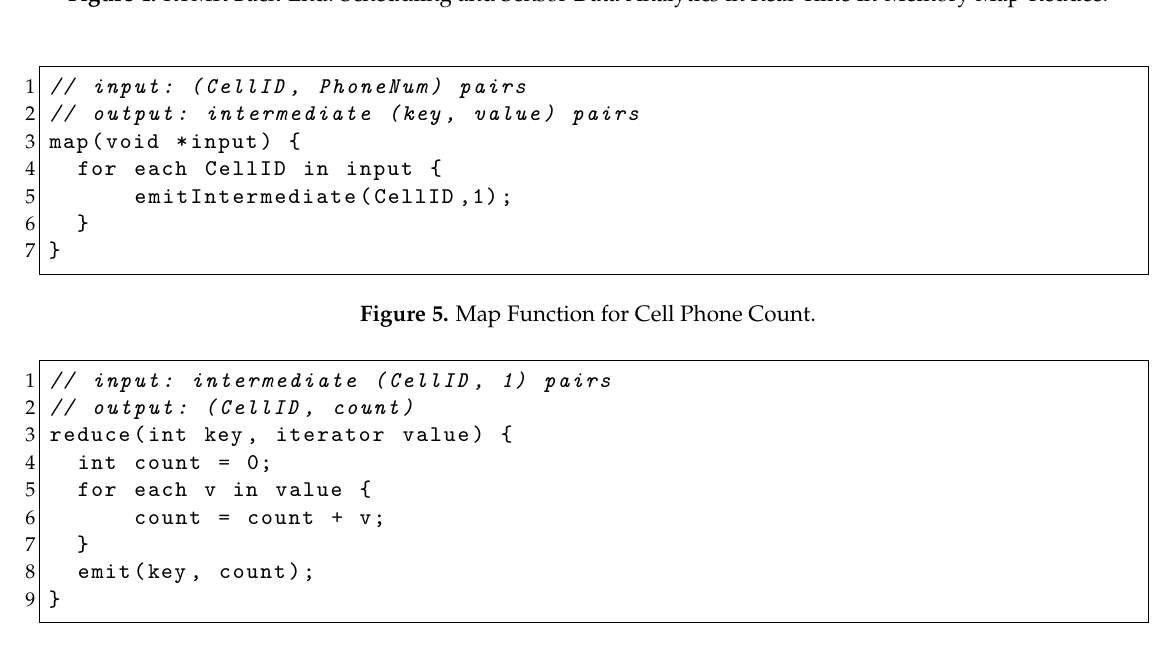
Figure 6. Reduce Function for Cell Phone